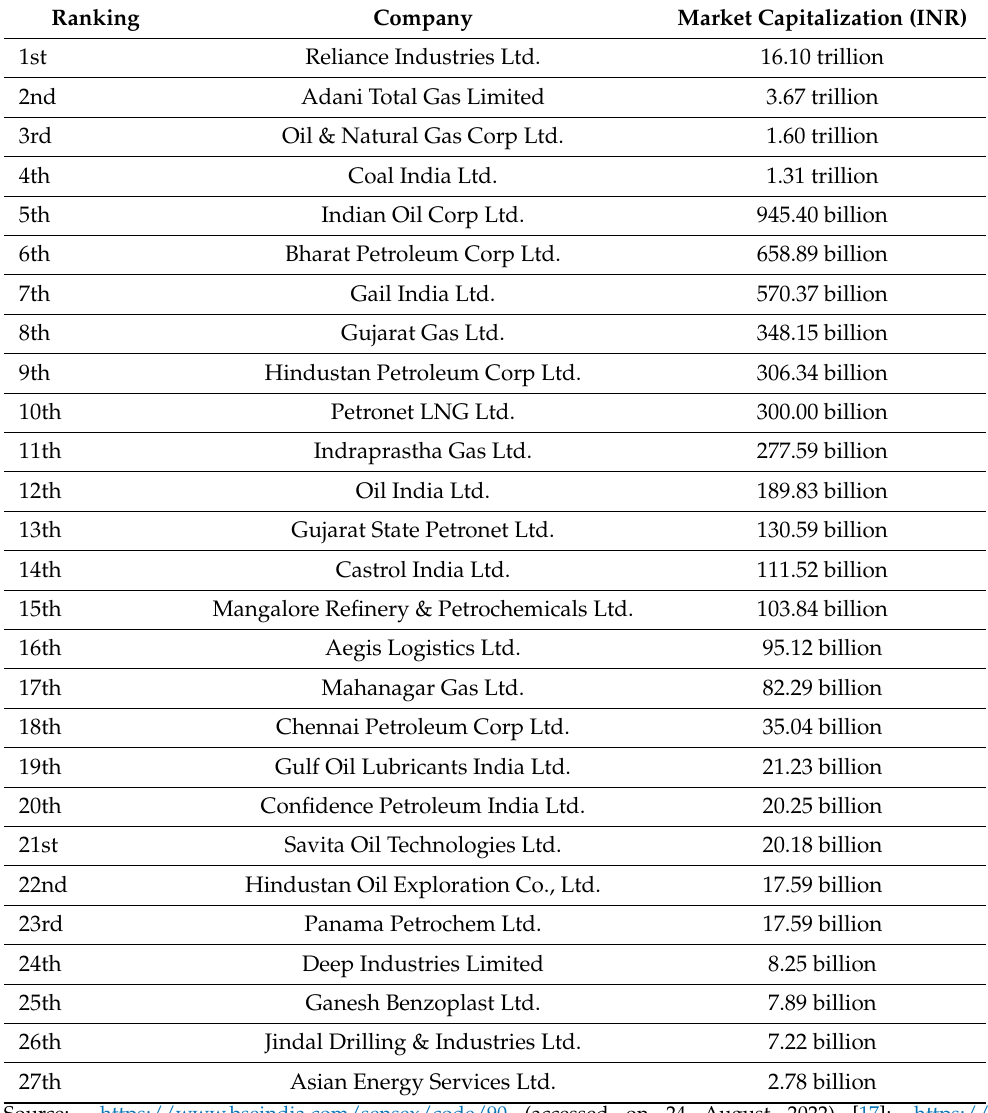
Table 2. S&P BSE Energy Index